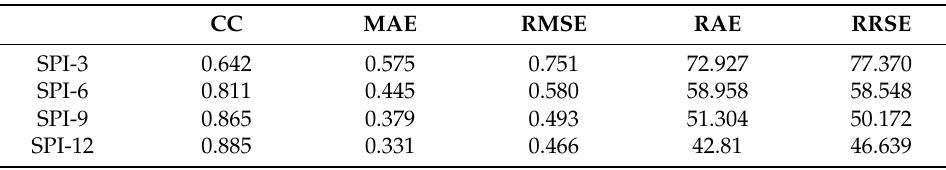
Table 7. Performance validation of SVM at sub-basin 2.